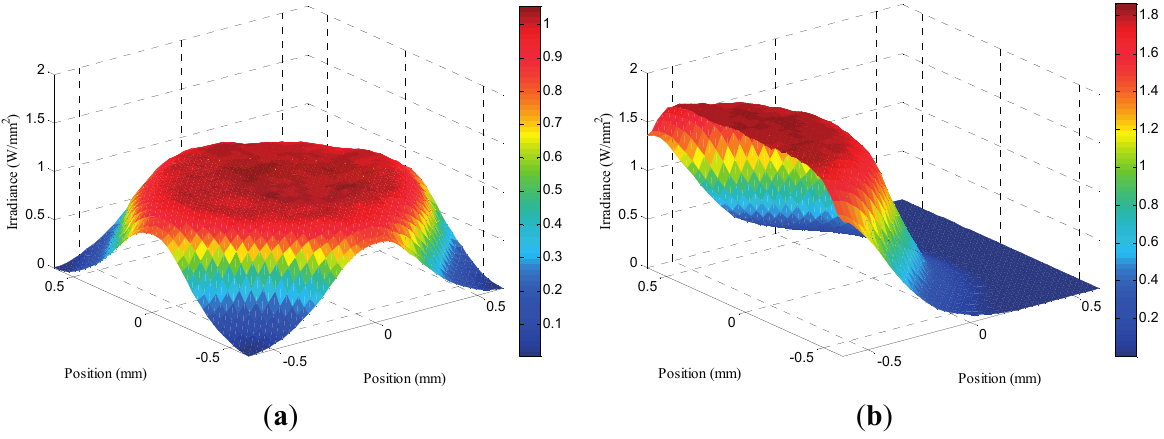
Figure 20. Irradiance distribution on the receiver for the Fresnel lens with SP II-type SOE ( a ) under normal incidence; ( b ) incidence angle = 0.7°.